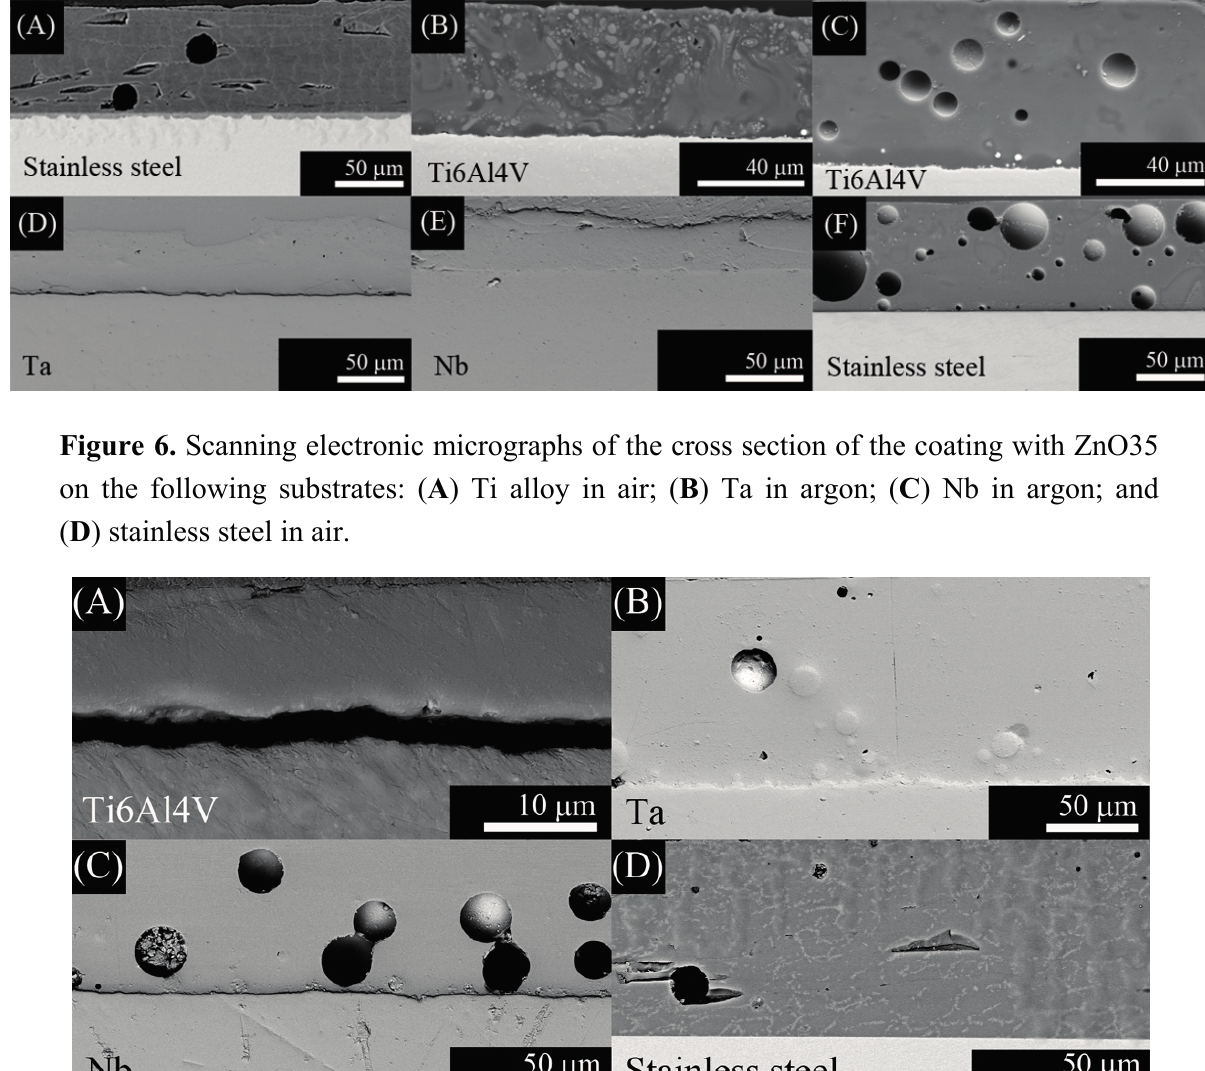
Figure 5. Scanning electronic micrographs of the cross section of the coating with: ( A ) G3 on stainless steel and with ZnO15 on the following substrates; ( B ) Ti alloy in argon; ( C ) Ti alloy in air; ( D ) Ta in argon; ( E ) Nb in argon; and ( F ) stainless steel in air.